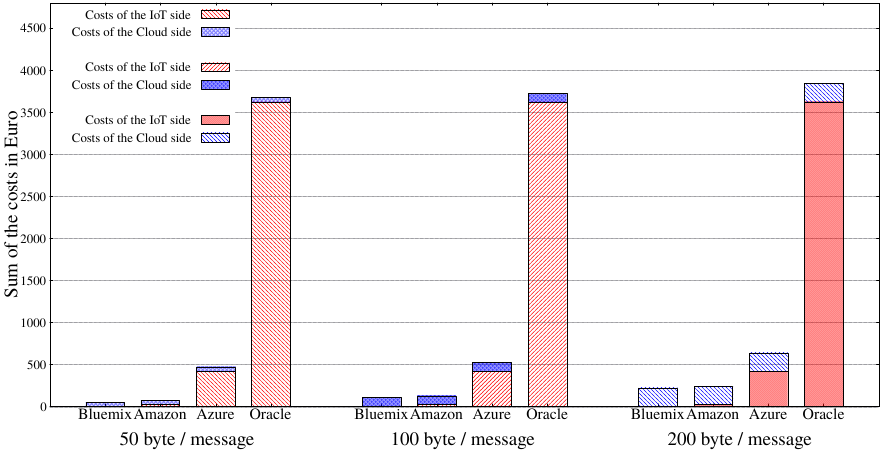
Figure 7. Number of virtual machines in scenario N o 1.